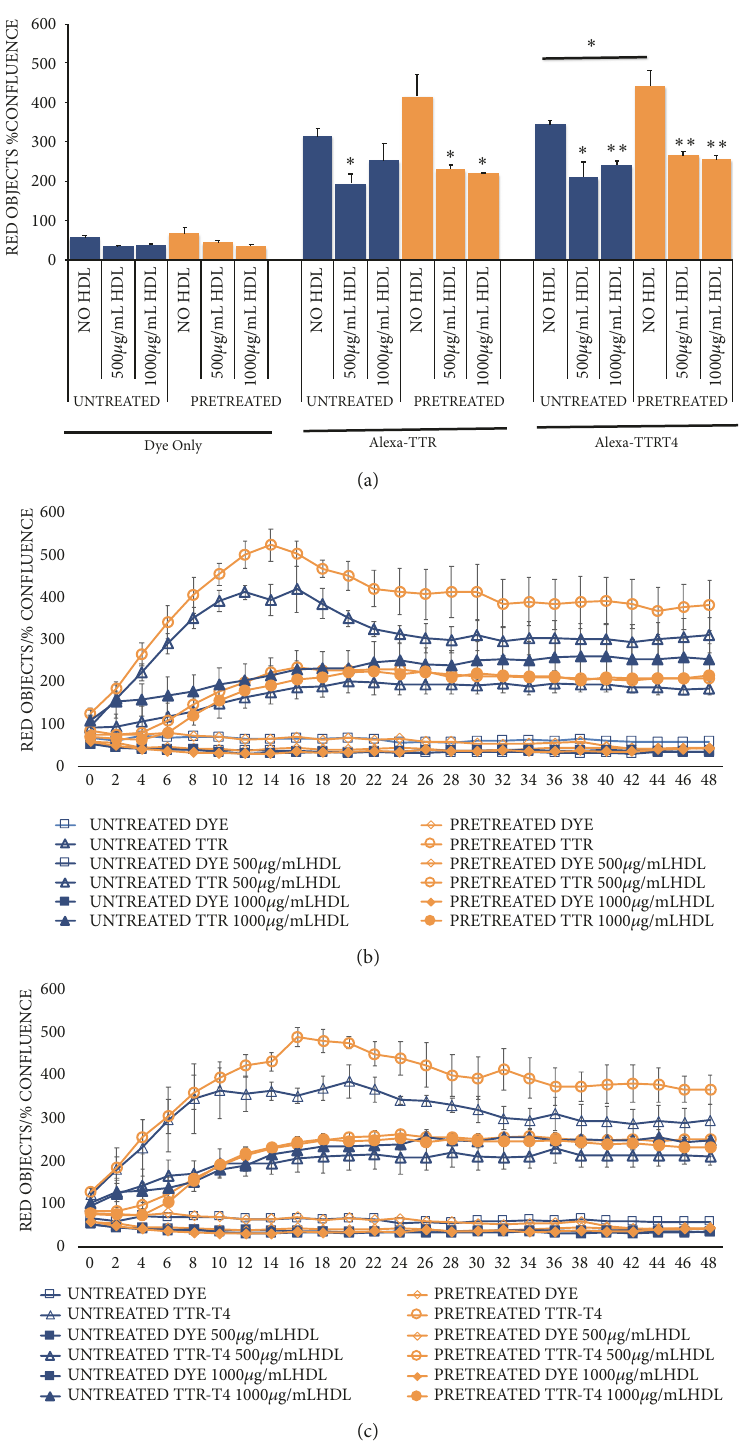
Figure 2: The effects of high density lipoprotein (HDL) treatment on TTR and TTR-T4 uptake in HepG2 cells. Cells were serum starved for 4 hours before uptake experiments. 500 ug/ml HDL was added to the serum free medium during this 4-hour period for the HDL ‘pretreated’ group. Medium was removed and replaced with serum free medium containing unconjugated Alexa dye, Alexa-labelled TTR, or Alexa- labelled TTR-T4 ( ± 500/1000 ug/ml HDL) and cells were transferred to an Essen IncuCyte incubator where intracellular fluorescence and cell confluence (%) were measured every 2 hours. Alexa-TTR uptake is expressed as red objects/% confluence. (a) Relative uptake of dye, Alexa-TTR, and Alexa-TTR-T4 at 24 hours. Pretreatment with 500 ug/ml HDL for 4 hours resulted in greater uptake of Alexa-TTR-T4 at 24 hours (p < 0.05, n=4). Cotreatment with 500 ug/ml HDL resulted in reduced uptake of Alexa-TTR and Alexa-TTR-T4 in all conditions tested. Coincubation with 1000 ug/ml HDL reduced uptake of Alexa-TTR in cells pretreated with HDL only. 1000 ug/ml HDL reduced uptake of Alexa-TTR-T4 in both control and pretreated cells (n=4, ∗ p < 0.05, ∗∗ p < 0.01). (b) Uptake of Alexa-TTR over 48 hours. Coincubation with HDL reduced Alexa-TTR uptake under all conditions (n=4). (c) Uptake of Alexa-TTR-T4 over 48 hours. Coincubation reduced Alexa-TTR- T4 uptake under all conditions